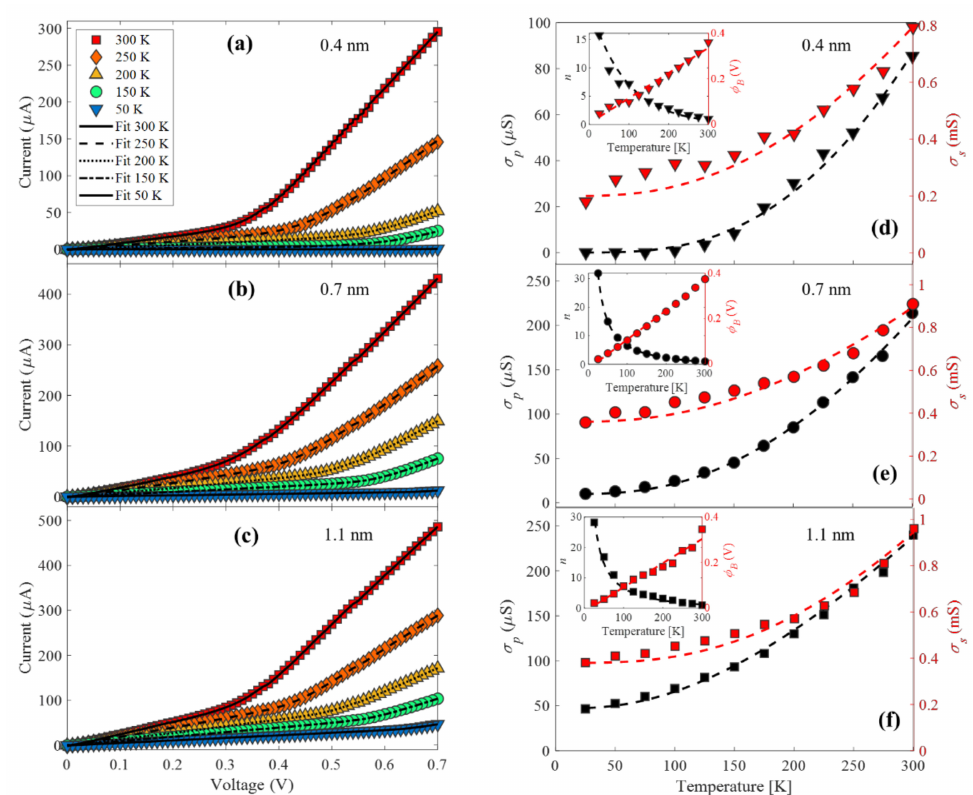
Figure 7. ( a – c ) I–V curves measured at 300 K, 250 K, 200 K, 150 K, and 50 K of samples that contain LC-CNTs with 0.4 nm, 0.7 nm, and 1.1 nm of wall thickness, respectively. ( d – f ) are the plot of the conductance σ p = 1/ R p and σ s = 1/ R s as a function of temperature for each sample, the insert shows the ideality factor and the average barrier voltage φ B as a function of